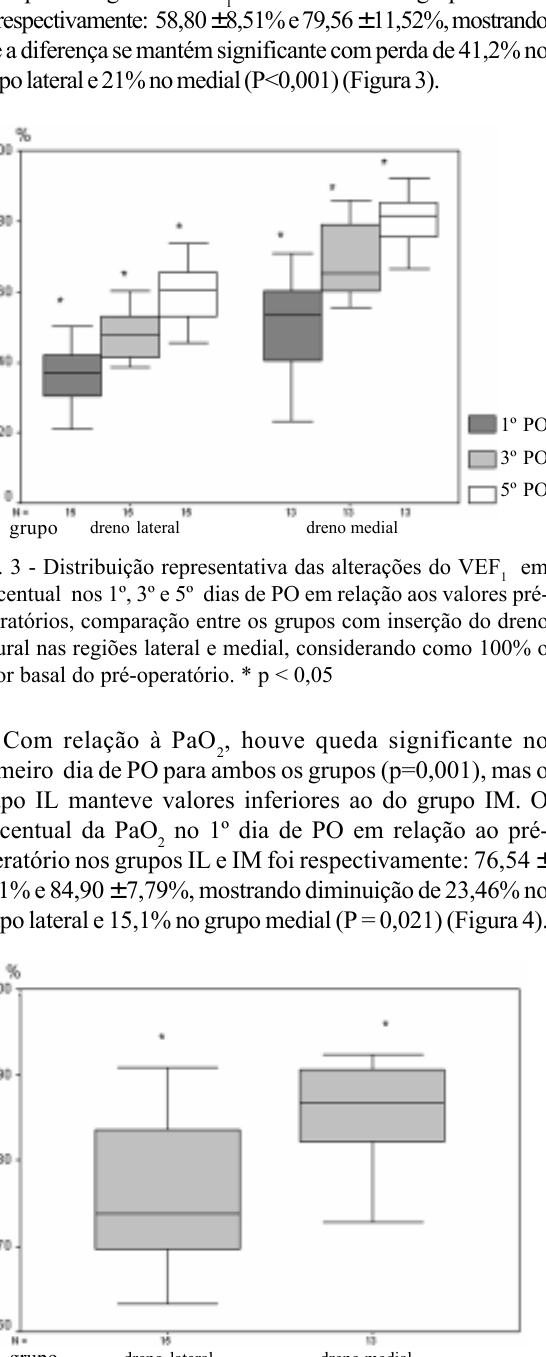
foi respectivamente: 58,80 ± 8,51% e 79,56 ± 11,52%, mostrando que a diferença se mantém significante com perda de 41,2% no grupo lateral e 21% no medial (P<0,001) (Figura 3).